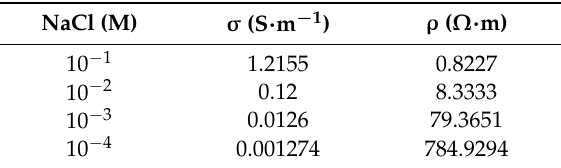
Table 4. Conductivity and resistivity values of the four sodium-chloride solutions used to determine the geometric factor value of each electrode